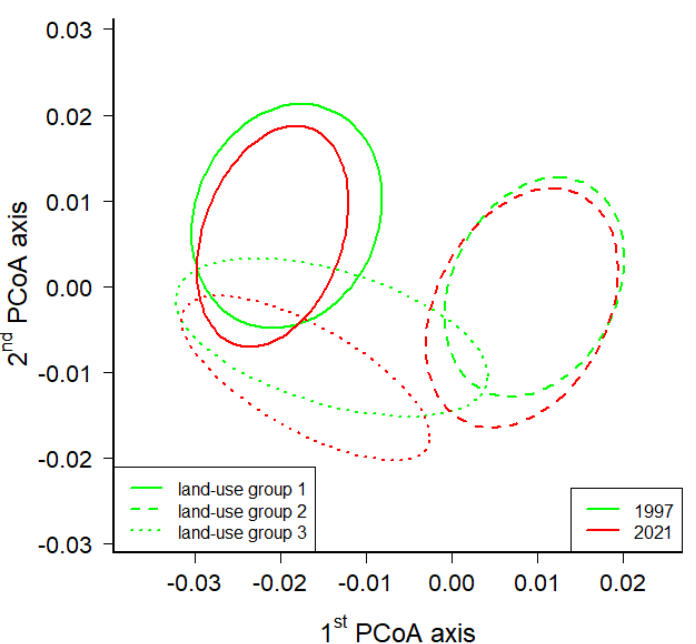
Figure 5. The principal coordinates analysis (PCoA) of the floristic data (Sörensen dissimilarity) of 110 grid cells in Podyjí and Thayatal NPs and the Podyjí buffer zone from both floristic surveys (1997 and 2021) shows the shift in plant species composition within three groups of grid cells clustered on land cover observed in 1950. Ellipses are drawn around the medoids of three groups of cells based on the classification of land-cover data detected in the 1950s (see Methods); if they do not overlap, the groups differed. Table 2. Variables tested in the distance-based redundancy analysis (db-RDA; Sörensen dissimilar- ity, Hellinger distance; geological diversity filtered as a covariate), assessed the variation of the whole model and then tested using forward selection with an adjusted R 2 and Holm’s correction.